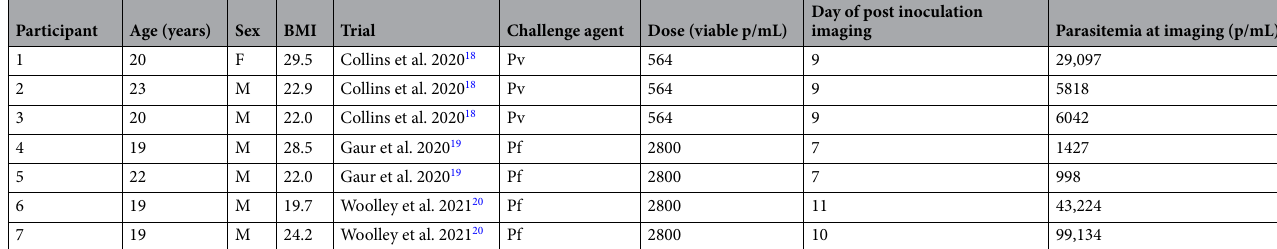
Table 1. Study population information. Parasitemia at imaging: estimated by interpolating the linear rate of change between the closest log-transformed parasitemia measurements. BMI body mass index, Pv P. vivax, Pf P.